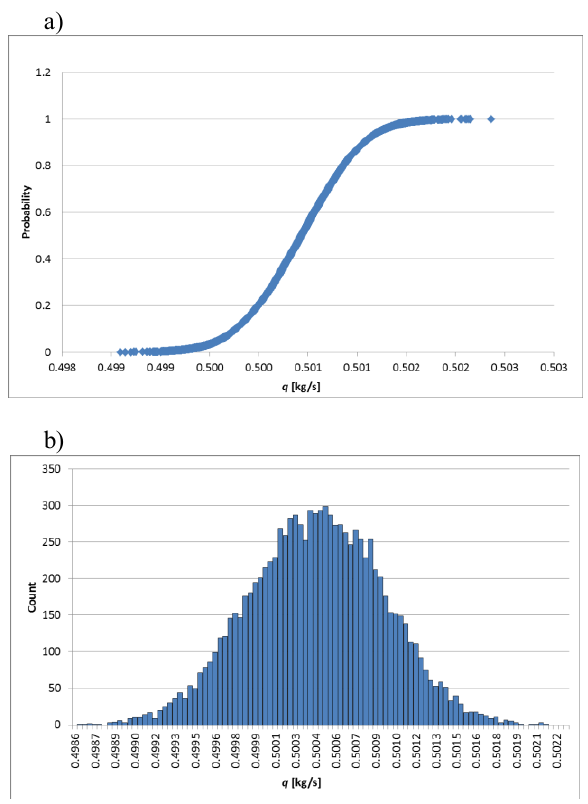
Fig. 3. Simulated outflow distribution (a) and histogram (b) for the mass flow q =0.5004 kg/s.